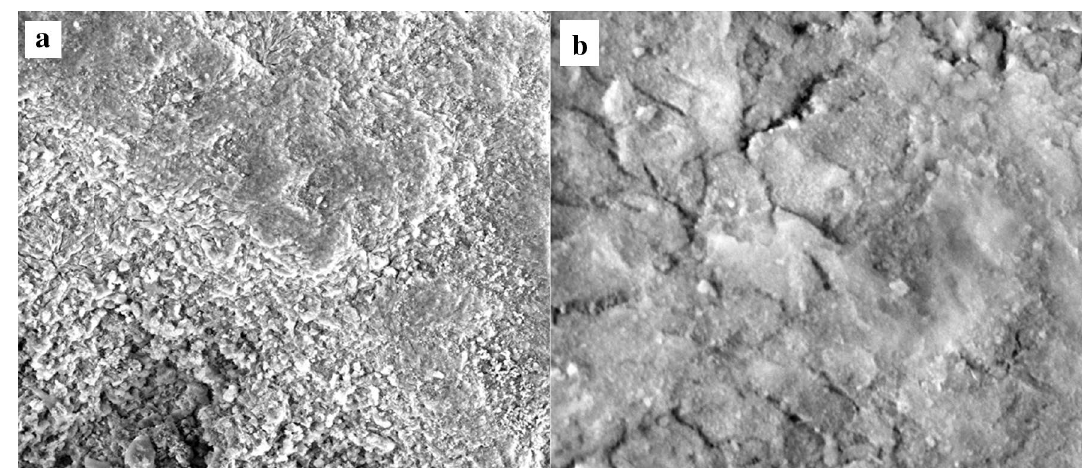
Figure 3. SEM images of the catalyst CoMo/γ-Al 2 O 3 -HMS a 100 µm and b 5 µm image scale